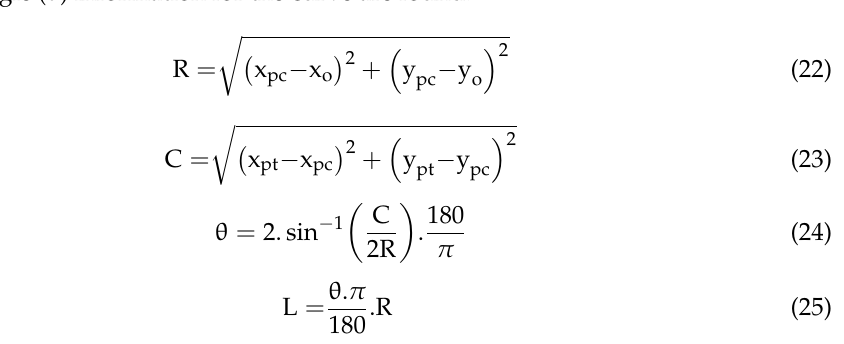
Figure 6. Curve classes: ( a ) simple curve, ( b ) compound curve, ( c ) compound and simple curve. After the start and end points of the curve are determined, the length ( L ), radius ( R ), and center angle ( θ ) information for the curve are found.